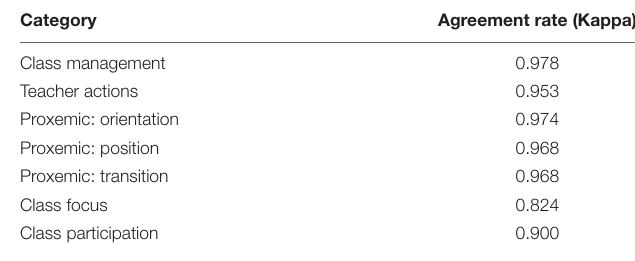
TABLE 3 | Inter-rater agreement